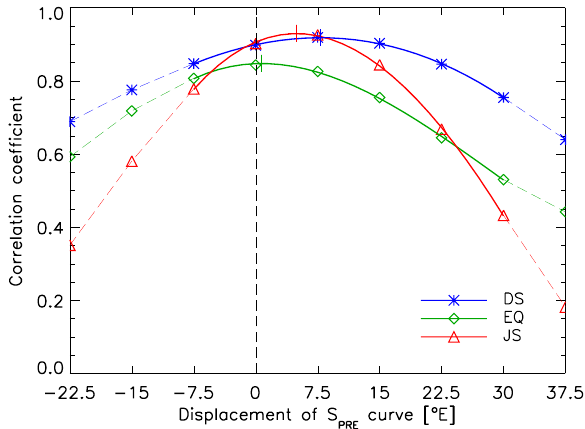
Fig. 4. Cross-correlation between S PRE and the ESF occurrence rate plotted versus the longitudinal shift of S PRE location. Peak locations of the approximated functions (solid lines) are marked by vertical dashes